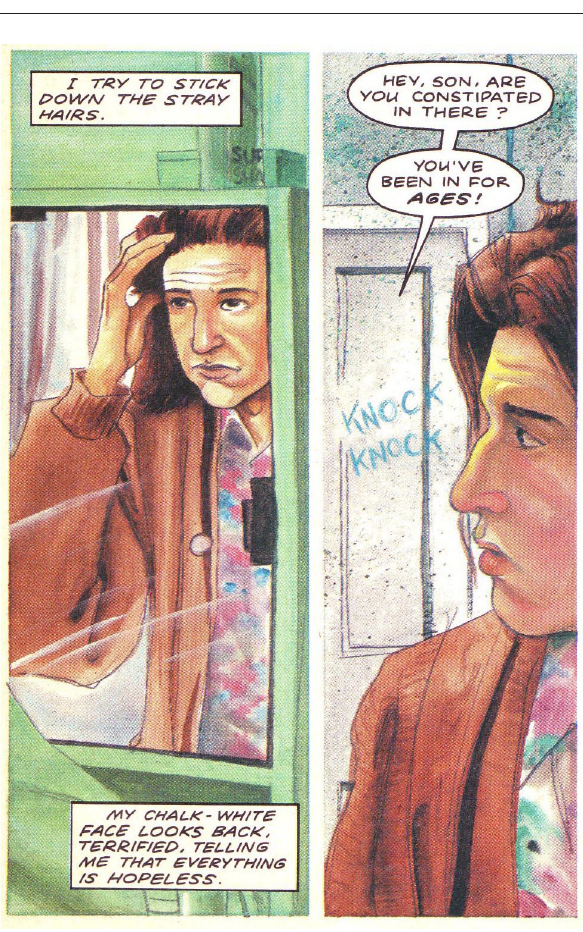
Fig. 1: Millar and McCrea, Crisis #31 (1989)